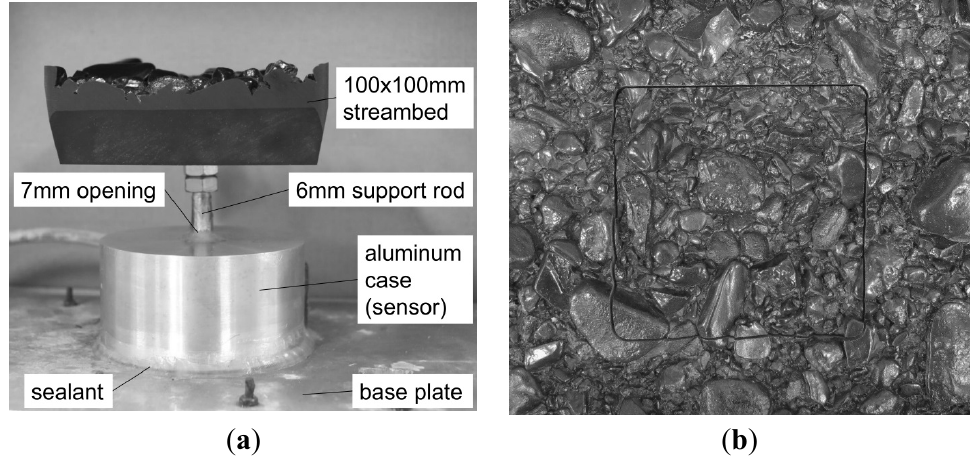
Figure 5. ( a ) Target piece on sensor; ( b ) Target piece in position.